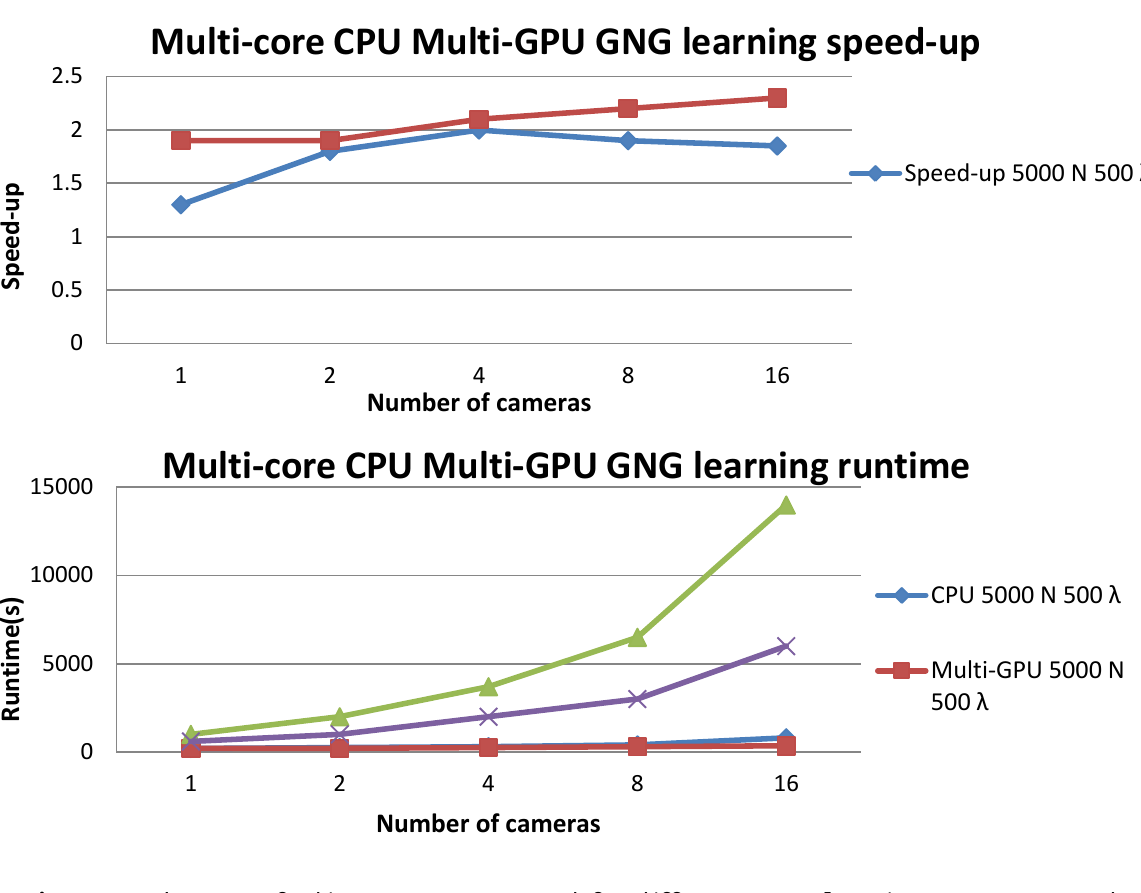
Figure 9. The rate of adjustments per second for different GNG learning parameters and different numbers of cameras using the multi-GPU-multi-CPU and single-threaded CPU